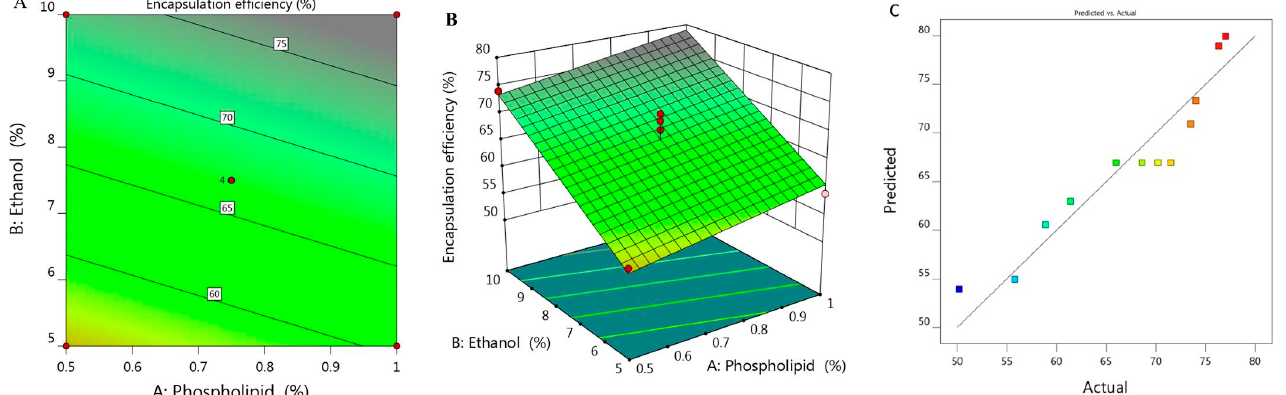
Figure 2. ( A ) 2D contour graph, ( B ) 3D response surface plot demonstrating the influence of independent variables (X 1 ) and (X 2 ) on encapsulation efficiency (Y 2 ) and ( C ) linear correlation plot between actual and predicted values for response (Y 2 ).